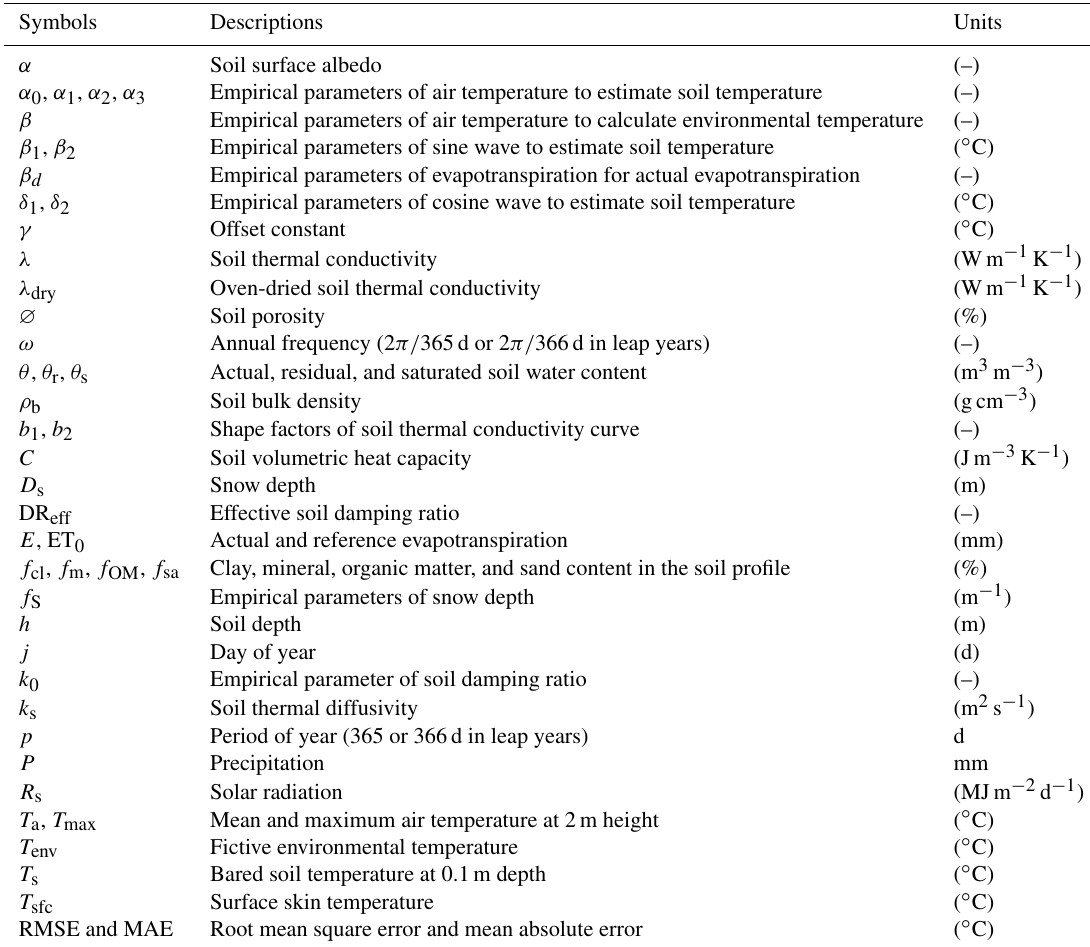
Table A1. Table of symbols and corresponding descriptions used in this paper.